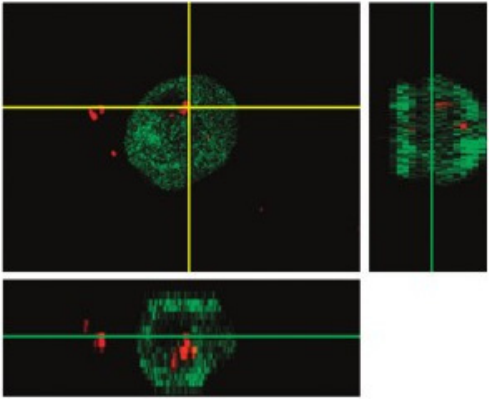
protein (GFP). The red color representing the labeled-chitosan appeared to be in the cytoplasmic compartment of the cell